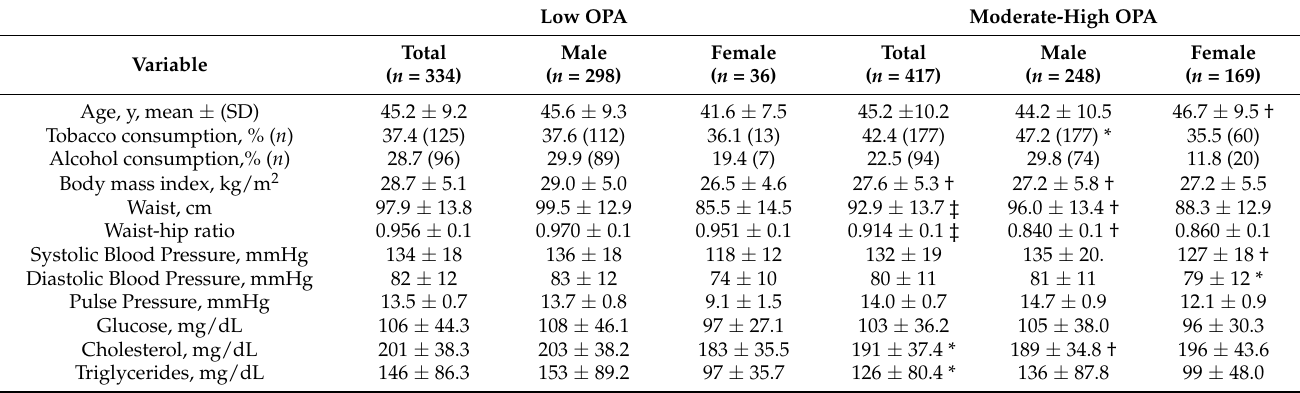
Table 1. Characteristics of the participants according to occupational physical activity